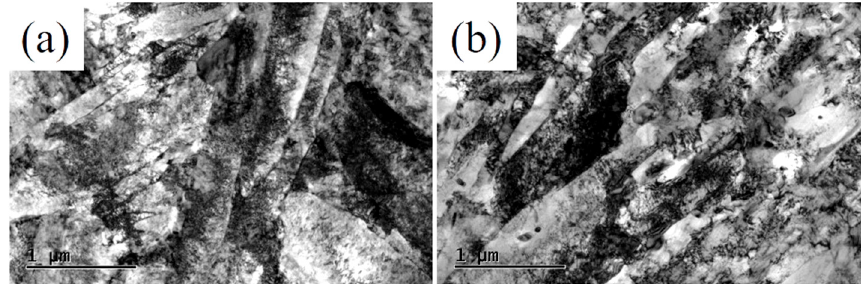
Figure 14. TEM microstructures of tempered samples: ( a ) novel steel and ( b ) 30SiMn2MoV.